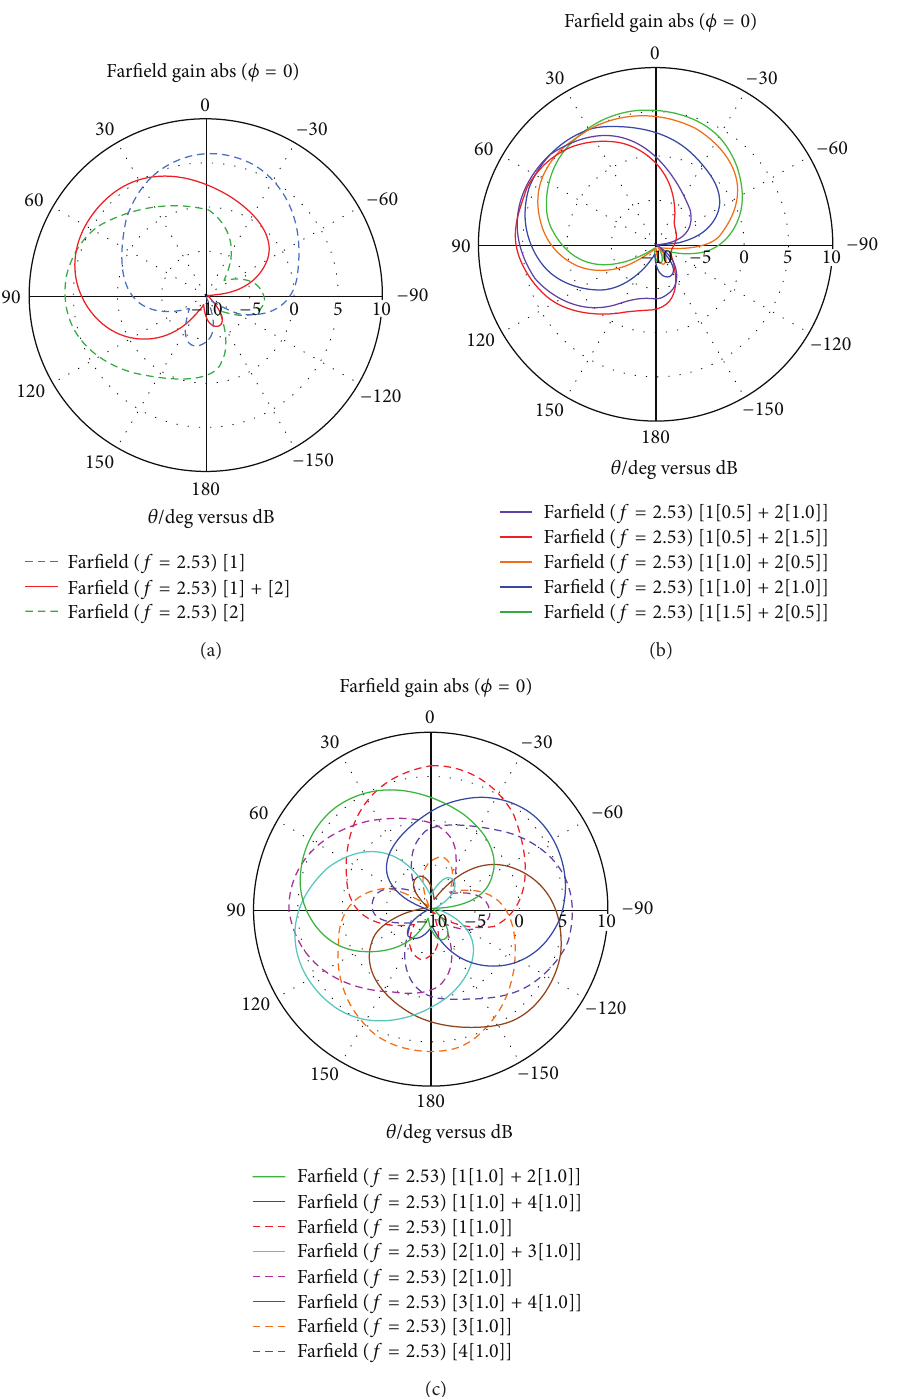
Figure 7: Radiation patters (a) two antennas and their resultant beam, (b) resultant beam of antennas 1 and 2 with different power feeding, and (c) resultant beams of possible